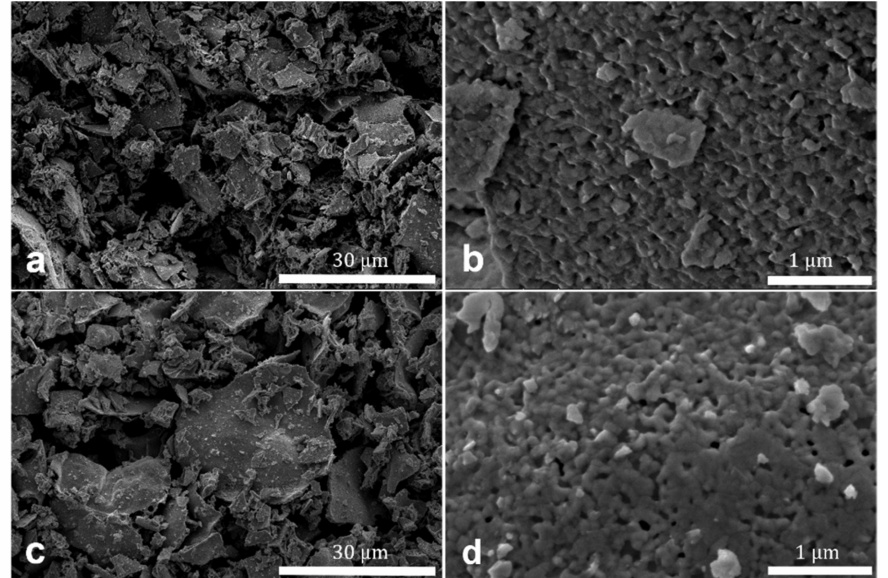
Figure 6. SEM images of NdNi before ( a , b ) and after a heating ramp ( c , d ) up to 500 ◦ C. All images were recorded with an acceleration voltage of 5 kV. ( a ) Overview, pristine; ( b ) selected area, pristine; ( c ) overview, after reaction; ( d ) selected area, after reaction. No significant changes to the material’s surface are visible.